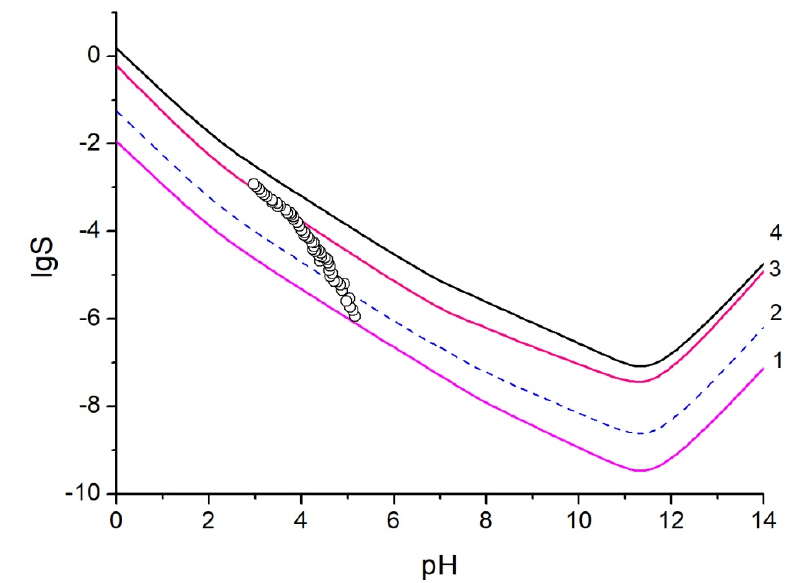
Figure 5. The solubility isotherms calculated according to the corrected solubility product values of the following calcium orthophosphates: 1—hydroxyapatite (−lgK S = 155); 2—Ca-deficient hydroxyapatite with Ca/P of 1.58 (−lgK S = 136.5); 3—Ca-deficient hydroxyapatite with Ca/P of 1.50 (−logK S = 113.8). Curve (4) is plotted for hydroxyapatite with the −logK S value of 116.8. Points in the figure are given according to the experimental data in Reference [19].